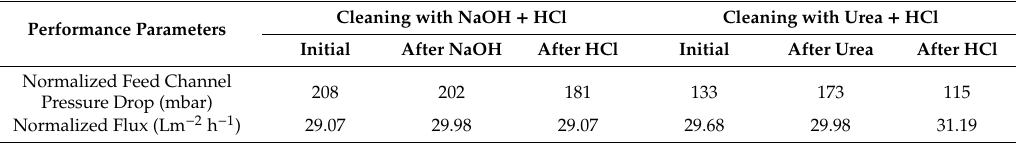
Table 2. Membrane performance parameters before, during and after